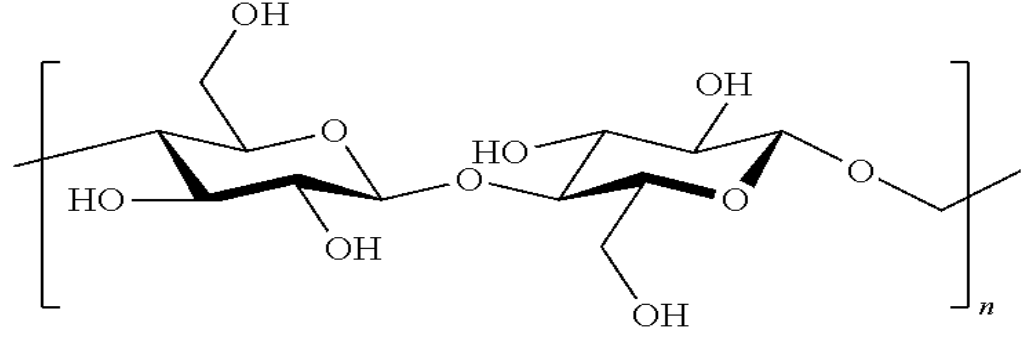
Figure 2. Cellulose structure.